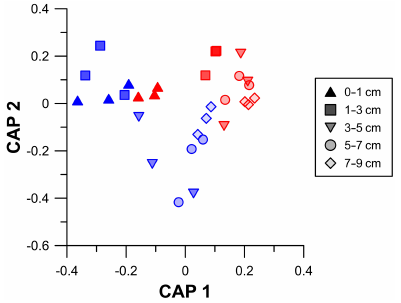
Figure 6. Variations in the biochemical composition of the sedi- mentary organic matter. Bi-plot after canonical analysis of the prin- cipal coordinates. Note that symbols represent the same core depth for both trawled (red) and untrawled (blue) sites and that increasing depth is also illustrated by a fading filling.